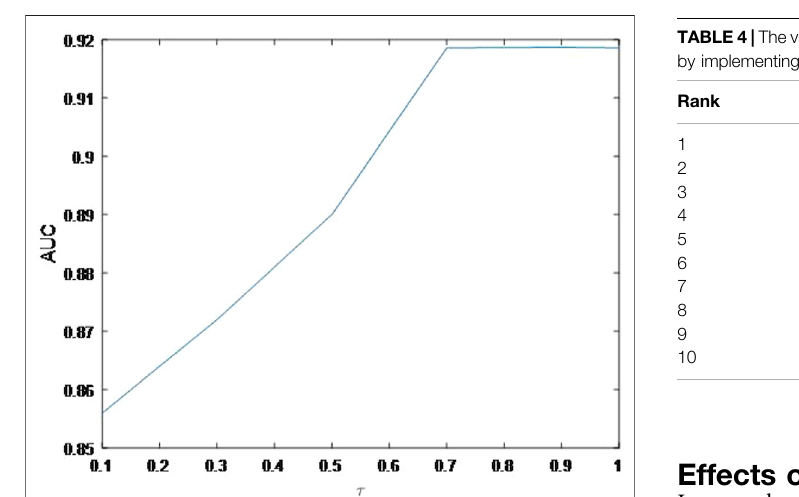
evaluate its predictive performance, where the AUC value of 1 represents perfect prediction ability, and the AUC value of 0.5 indicates random prediction performance (Chen et al., 2016a).